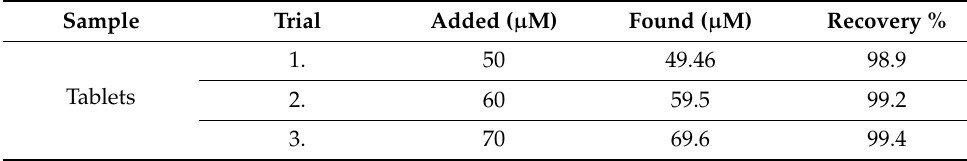
Table 2. Recovery data of LN in tap tablet